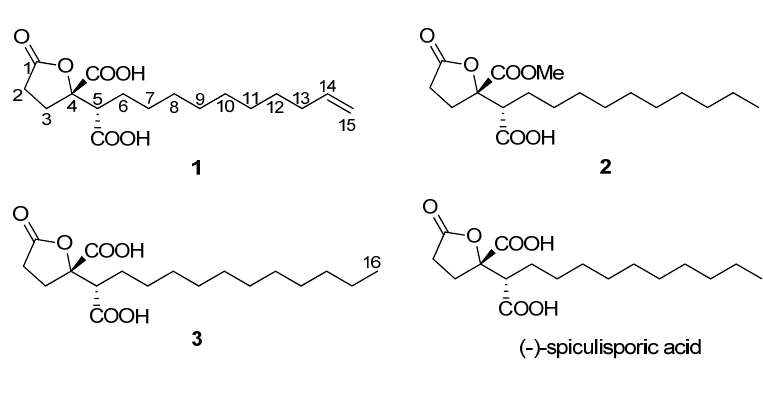
Figure 1. Structures of compounds 1 – 3